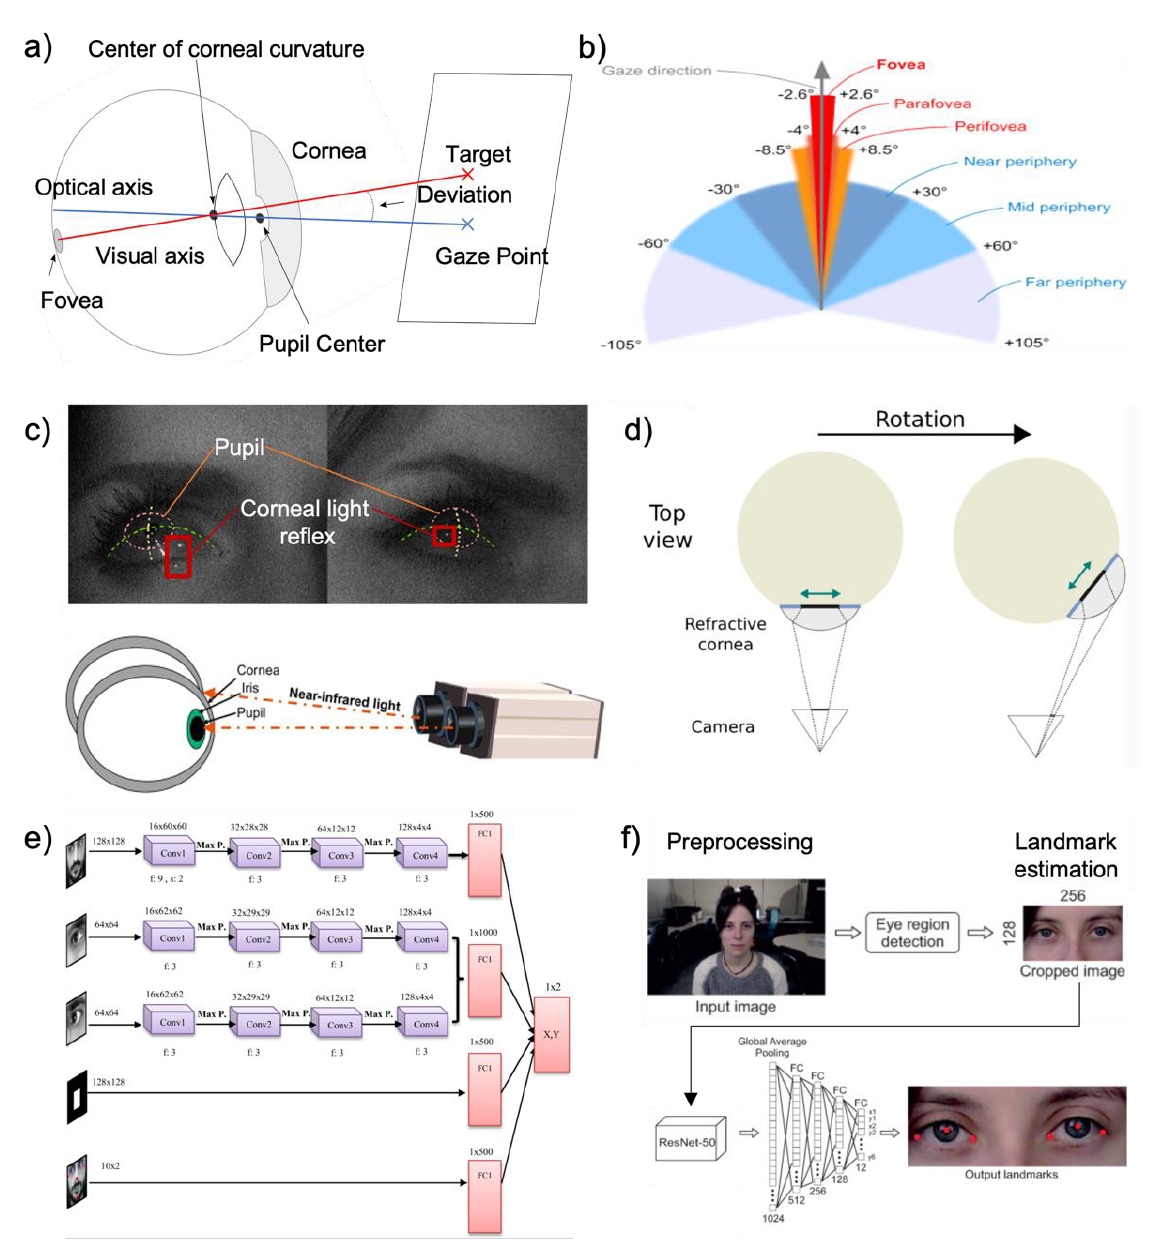
Figure 11. Eye movements and eye tracking technology. ( a ) Optical metric for human eye tracking